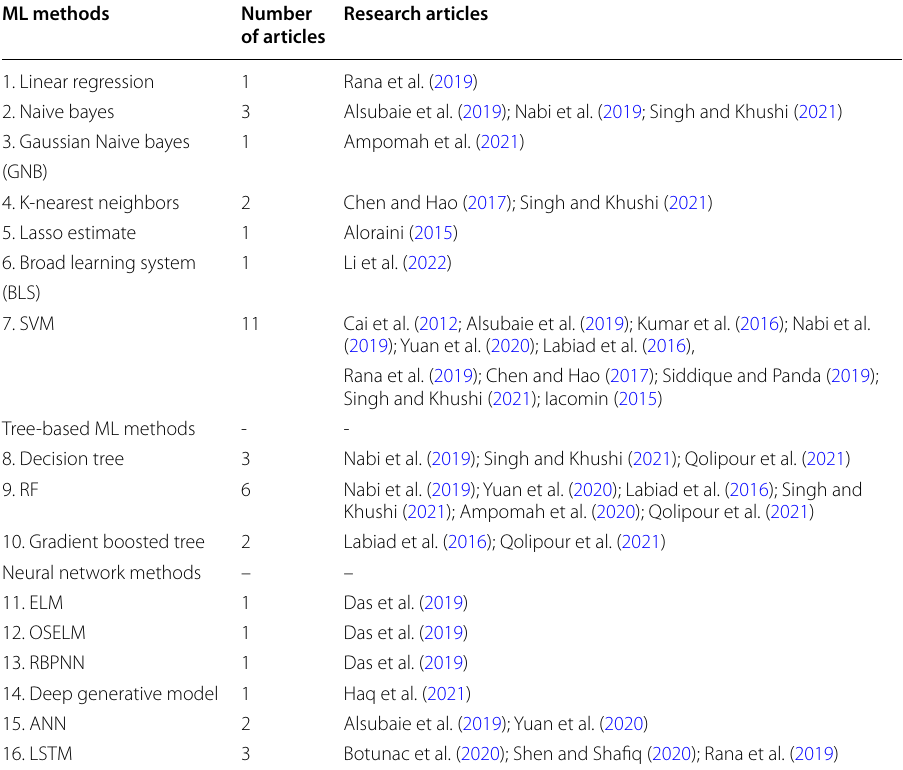
Table 4 ML methods applied in the reviewed papers ML methods